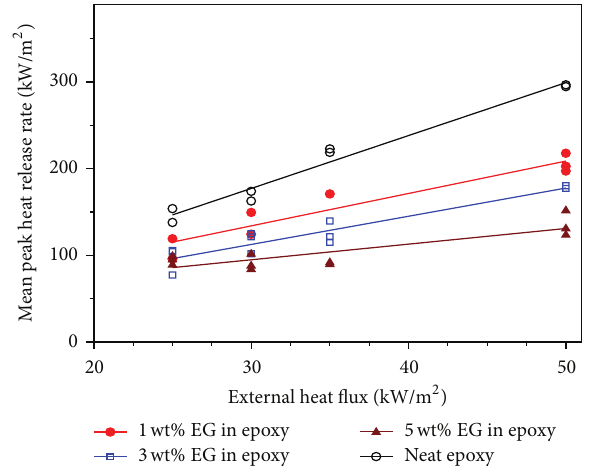
Figure 12: Heat of combustion of the composite samples. The slopes values for the samples neat, 1, 3, and 5-wt.% EG are 4.06, 3.49, 2.92, and 2.22, respectively. Table 5: Heats of gasification ( 𝐿 ), combustion ( Δℎ 𝑐 ), and net